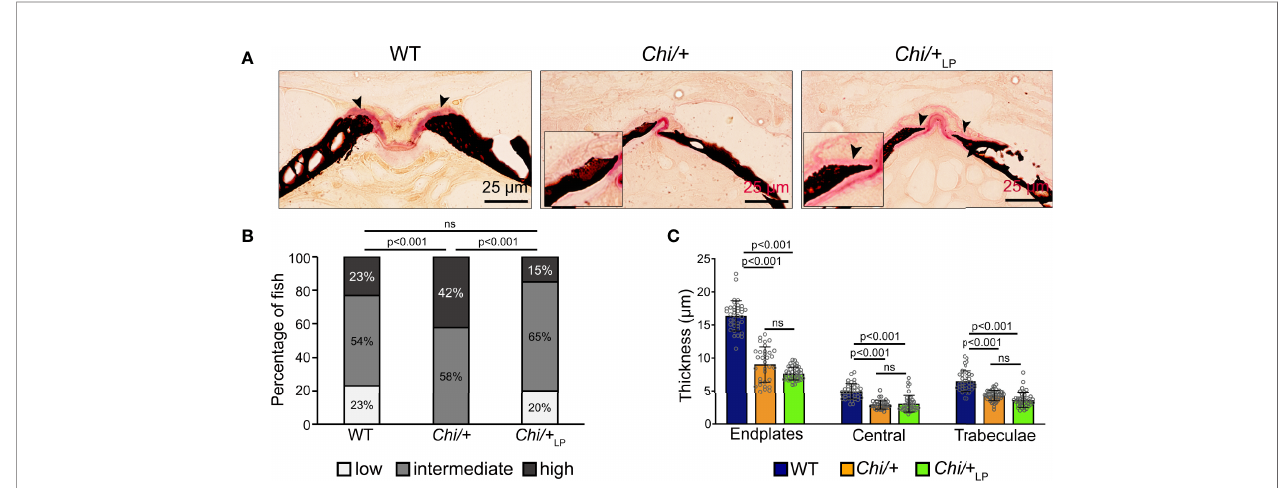
FIGURE 4 | Chi/+ vertebral bone structures are thin and highly mineralised. The LP diet restores the osteoid. (A) Sagittal histological non-demineralised sections stained with Von Kossa/Van Gieson show that three months old Chi/+ animals, compared to WT animals, have highly mineralised endplates. No osteoid layer can be identi fi ed. The osteoid (pink, black arrowheads) is restored in Chi /+ LP . Mineralised bone: black; dense collagen and non-mineralised bone: red. (B) Quantitative analysis of vertebral body endplate mineralisation (scored as low, intermediate or high) based on whole mount-stained specimens shows that Chi/+ animals exhibit a higher degree of mineralisation compared to WT animals. The LP diet reduces mineralisation of the vertebral body endplates in some Chi/+ individuals. The fi rst 5 caudal vertebral centra in WT (n=15), Chi/+ (n=13) and Chi /+ LP (n=12) were analysed. Chi-square test followed by Bonferroni correction, p values are indicated, ns: non-signi fi cant. (C) Measurements of bone structure thickness at three locations: (i) vertebral endplates, (ii) central region of vertebrae and (iii) trabecular bone (see Figure 3A for locations). Compared to WT animals, Chi/+ and Chi /+ LP animals have thinner bone structures in all three locations (see also Table 2 ). Thickness of bone structures was measured on toluidine blue stained sections in 5 to 10 vertebral centra in WT (n=4), Chi/+ (n=4) and Chi /+ LP (n=5). Mann-Whitney test followed by Bonferroni correction, p values are indicated, ns: non-signi fi cant.